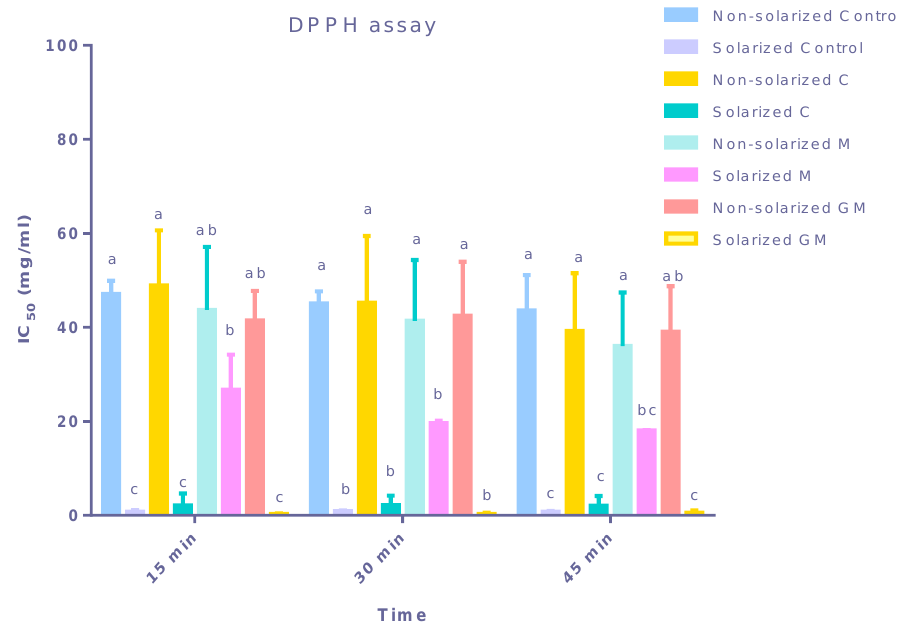
Figure 1. The antioxidant activity of four solarized samples and four non-solarized samples. Data are expressed as the mean of three experiments ± SD. Bars with different letters indicate mean values significantly different at p ≤ 0.05, according to a two-way ANOVA followed by NSK test.